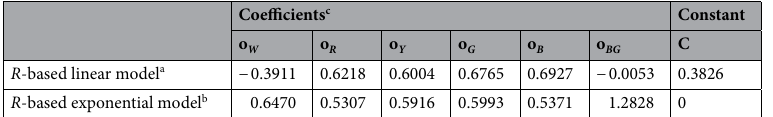
Table 3. In order to evaluate the accuracy of three-dimensional color prediction models, the average error values, that is, Δ L * 10 , Δ C * ab,10 , │ Δ h ab,10 │ , and Δ E CMC(2:1) , between the measured and the newly predicted colors of 105 test samples, were calculated and then compared with those of two-dimensional color prediction models. The results